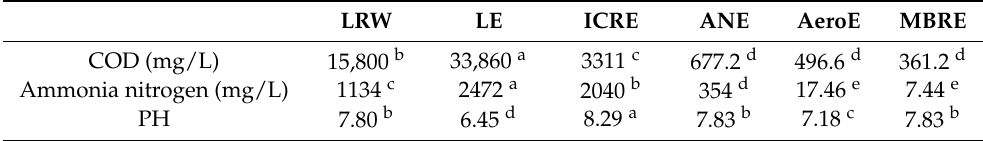
Table 2. Average values of leachate chemical